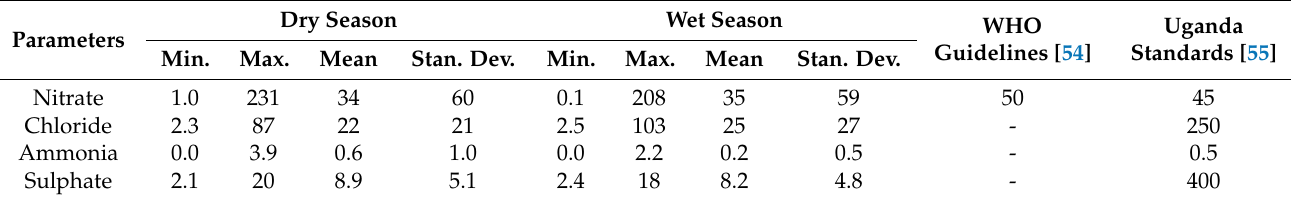
Uganda standard value for potable water of 0.5 mg/L. The Cl − and SO 42 − concentrations observed in the data were below the Uganda standard values for potable water. Table 2. Descriptive statistics of selected hydro-chemical parameters in sampled groundwater sources from the Bwaise informal settlement (values are given in mg/L; n = 17 for both wet and dry seasons).